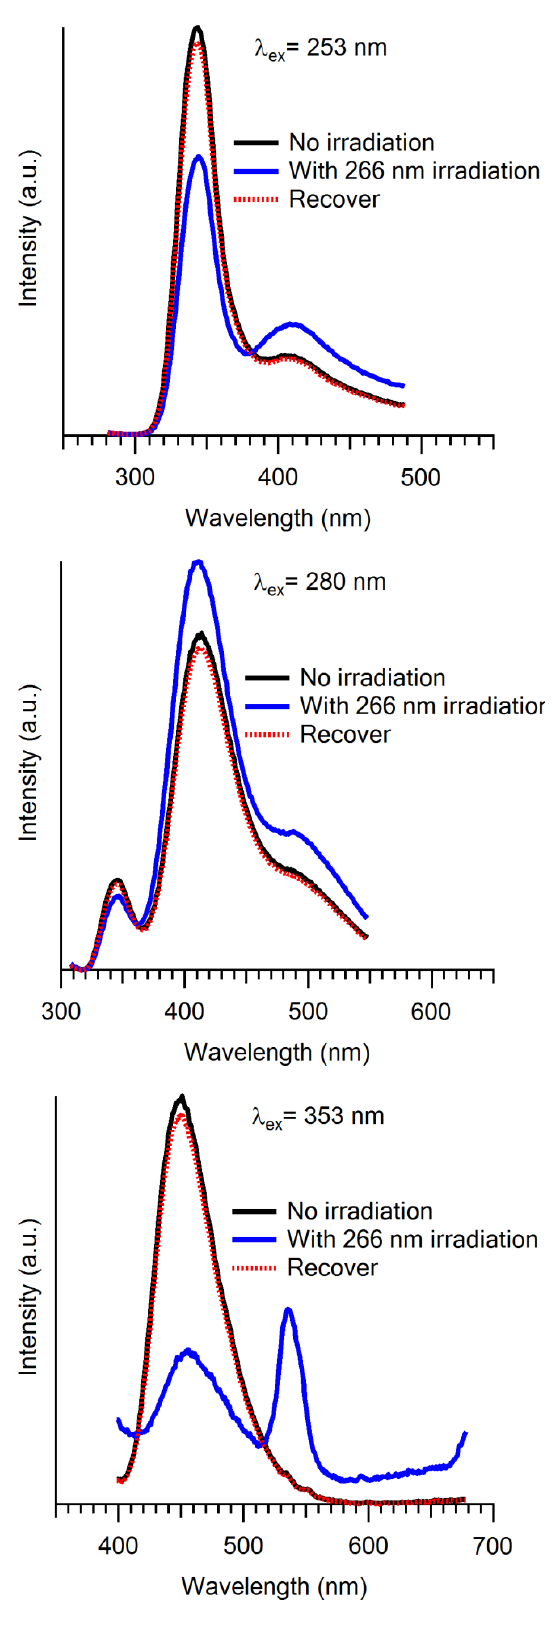
Figure 9. Emission spectra of Cu(CN) 2− doped in KBr at 77 K without laser irradiation (black solid), with 266 nm laser irradiation (blue solid), and recover, e.g., heat to room temperature then cool down to 77 K without laser irradiation (red dashed). (Reprinted with permission from [41]. Copyright 2012 American Chemical